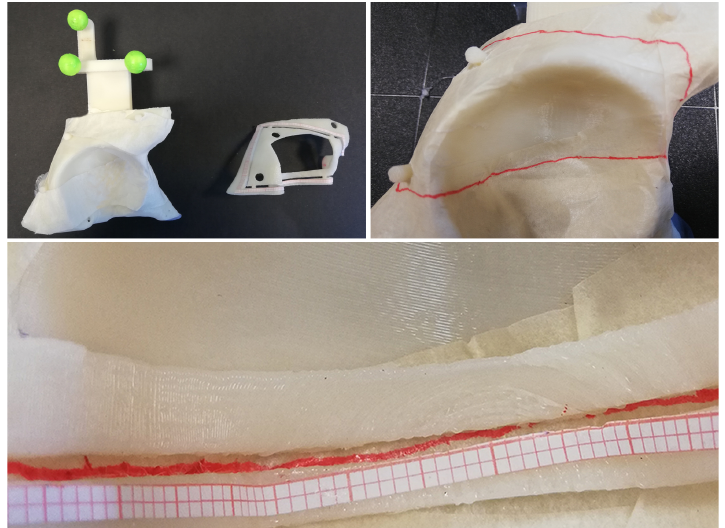
Figure 6. Top Left: 3D printed phantom for T3 with the 0.5 mm accuracy level template. Top Right: Example of a traced trajectory for the T3 task. Bottom: Zoomed detail of the traced T3 trajectory evaluated with the 0.5 mm accuracy level